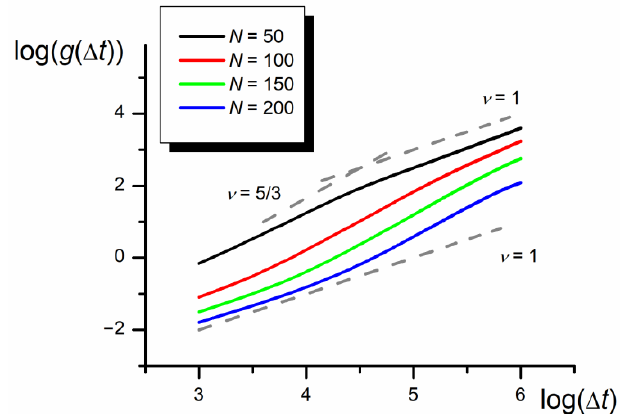
Figure 6. The log–log plot of the autocorrelation function, g, in nanochannels of di ff erent widths ( N = 100, ε PP / k B T = 0 and − 1 for P1 and P2, respectively). The slopes of di ff usion and quasi-ballistic modes (equal 1 and 5 / 3) are marked in gray.